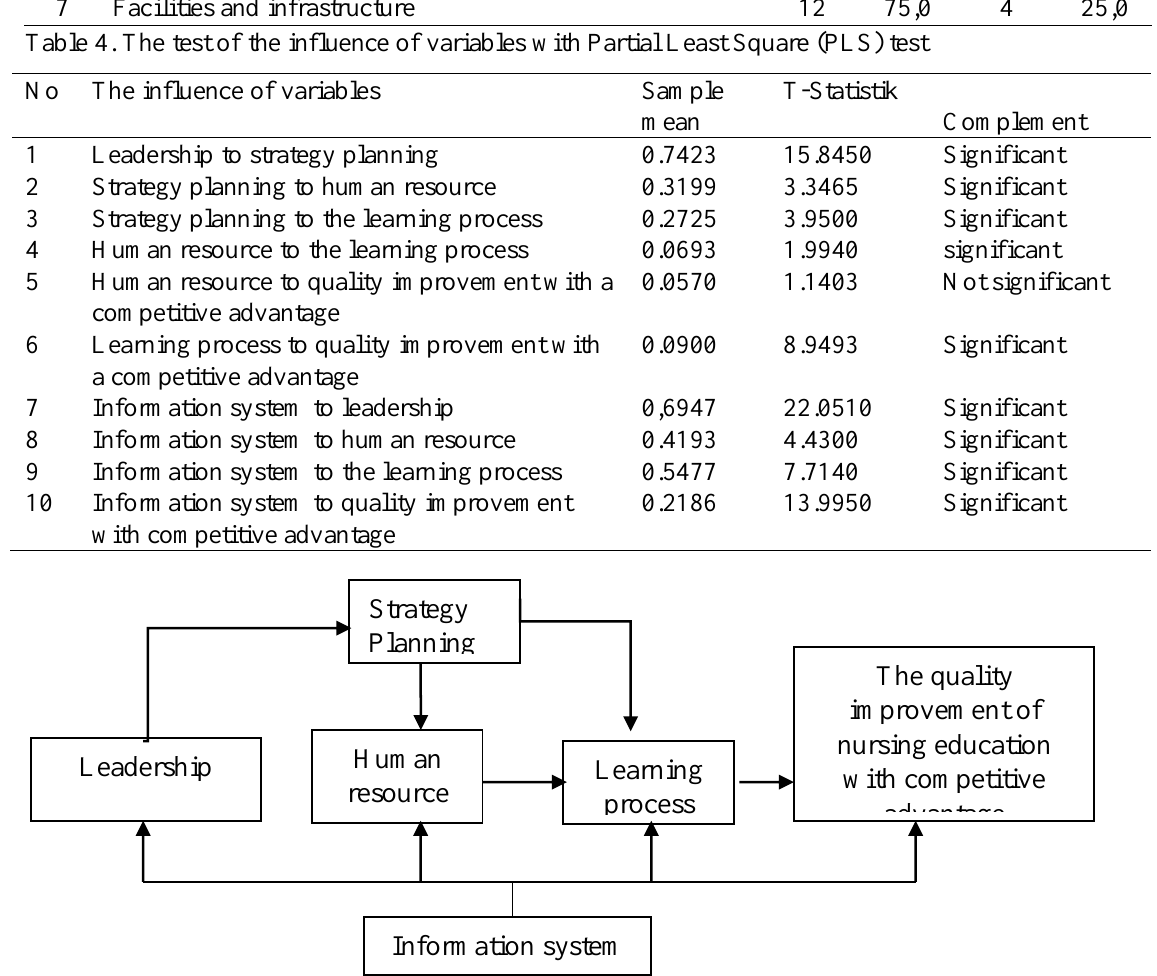
Figure 1. Quality development model of nursing education in the University of Muhammadiyah towards competitive